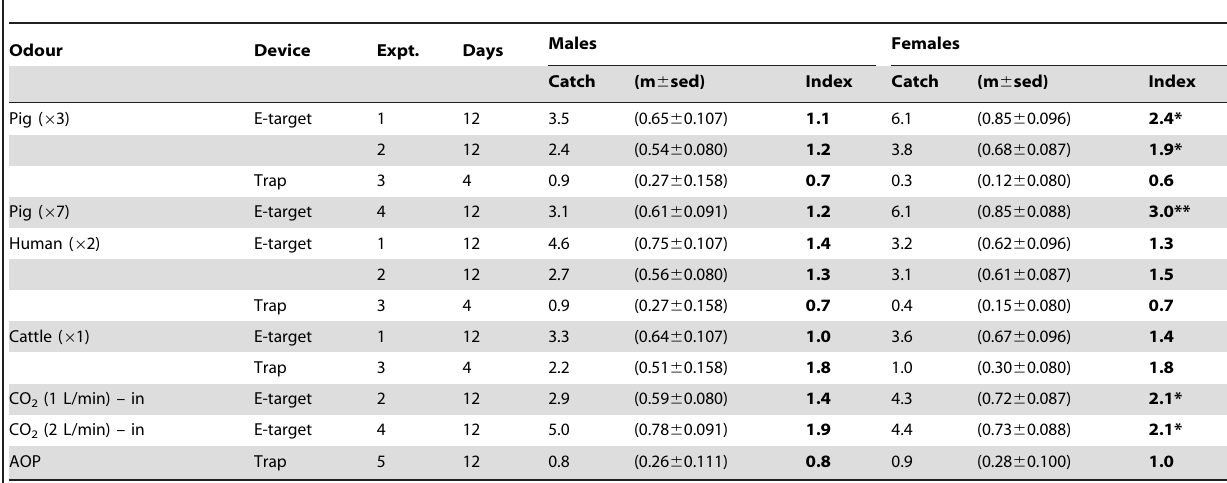
Table 2. Detransformed mean daily catches (transformed mean and standard error of the difference (SED) shown in brackets) of G. f. quanzensis from odour-baited devices operated in five experiments conducted in the Democratic Republic of Congo.